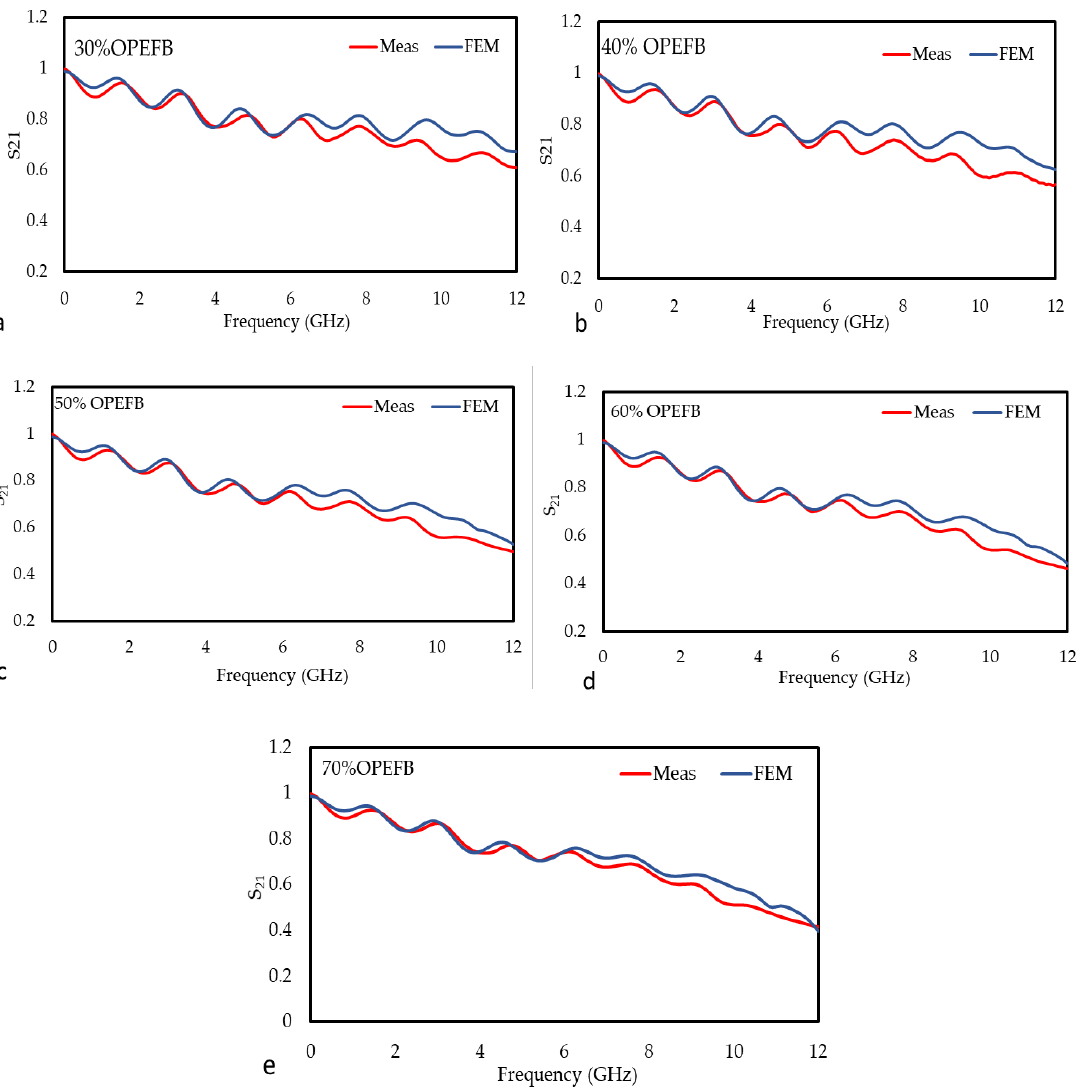
Figure 16. Variation in the magnitude of S 21 for the different OPEFB/PLA composites ( a ) 30 wt%, ( b ) 40 wt%, ( c ) 50 wt%, ( d ) 60 wt%, and ( e ) 70 wt% OPEFB for both the measurement and FEM simulation.